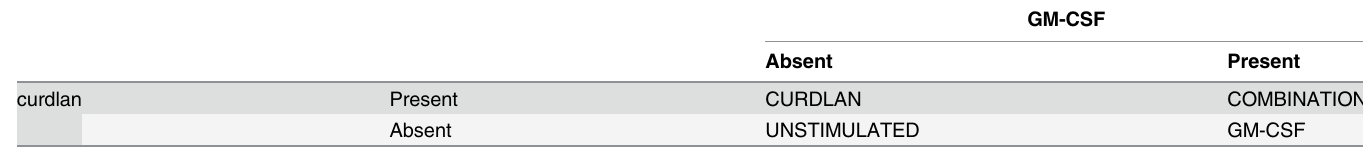
Table 3. Experimental design: Crossing of the treatments with curdlan (present/absent) and with GM-CSF (present/absent).